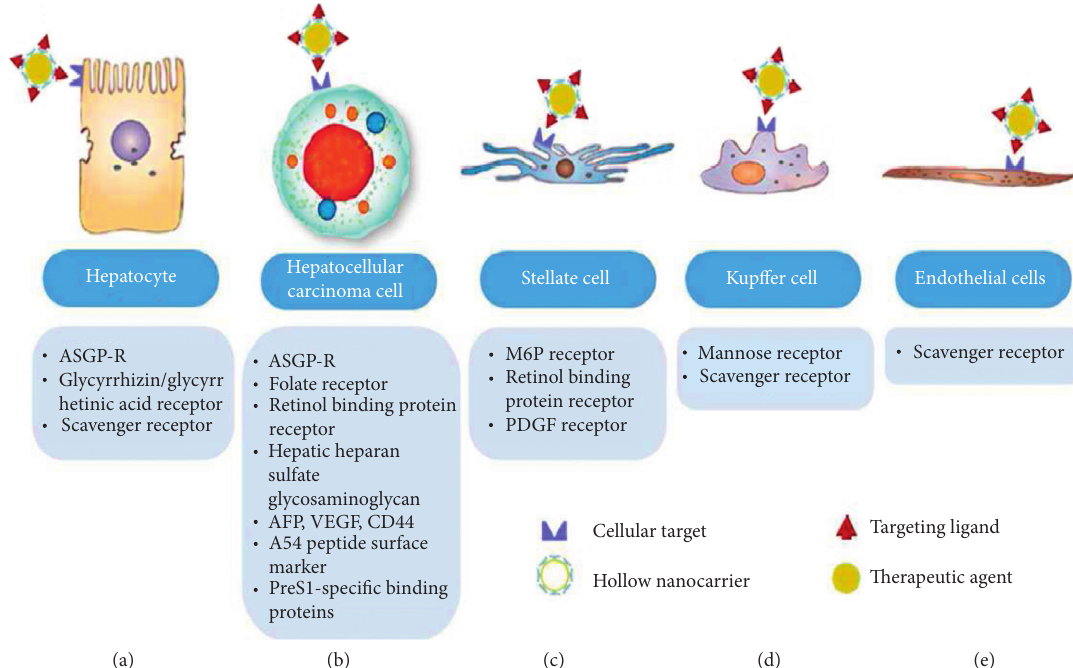
Figure 3: Receptors or cellular targets on liver cells for nanoparticles active targeting to the liver. (a) Hepatocyte, (b) hepatocellular carcinoma cell, (c) hepatic stellate cells (HSC), (d) Kupffer cell, and (e) endothelial cells (reproduced from [15] with permission from the Royal Society of